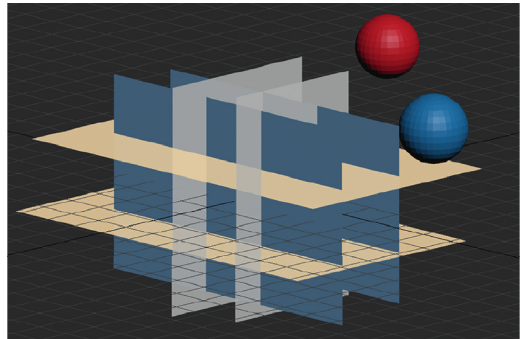
Figure 12: MBR model in Example 1(b).